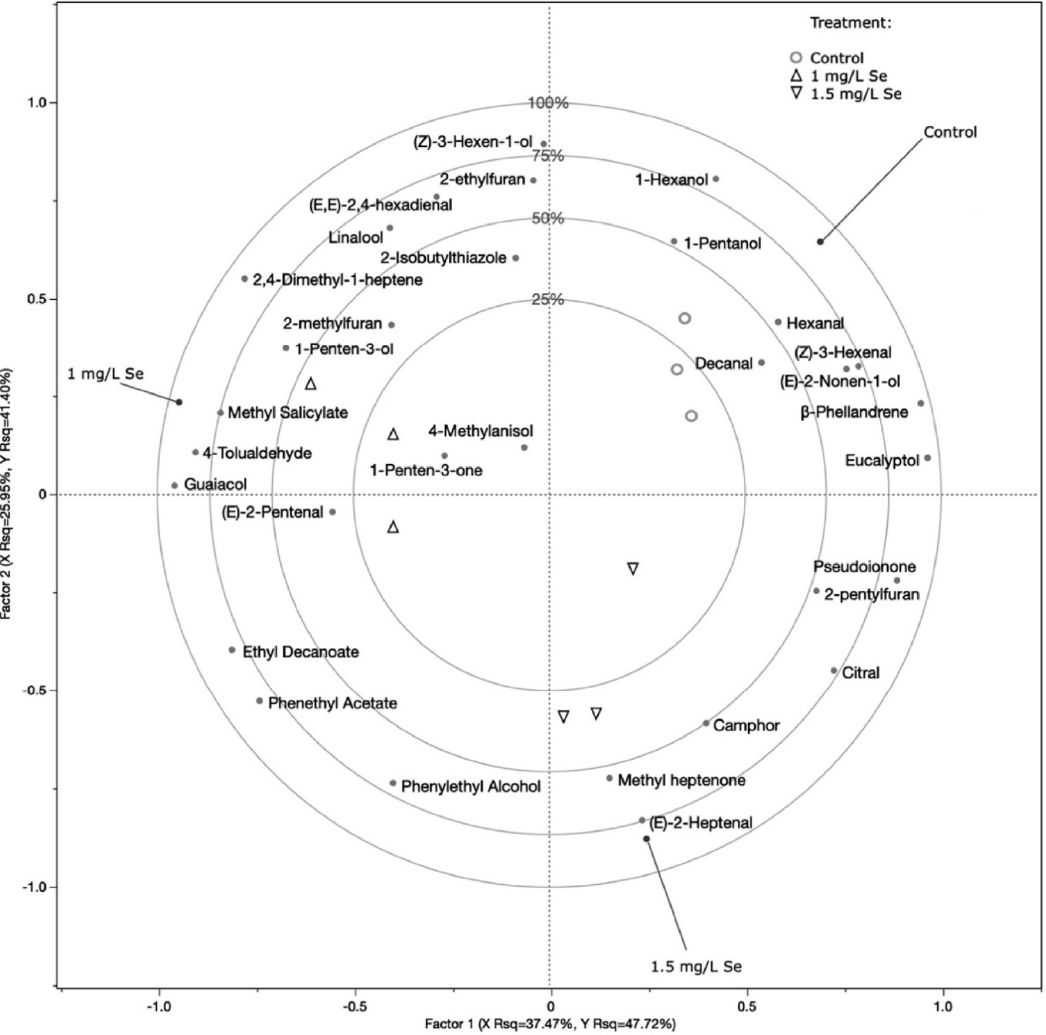
Figure 1. Partial least squares discriminant analysis (PLSDA). Treatment was employed as response variable, while the identified VOCs were used as predictor variables. Variable importance in projection (VIP) scores were used to filter compounds varying the most between different theses, and only compounds with a VIP score higher than 0.8 were included in the analysis. Circles, triangles, and inverted triangles were used to depict control fruit, 1 mg L − 1, and 1.5 mg L − 1 sodium selenate-treated fruit, respectively.